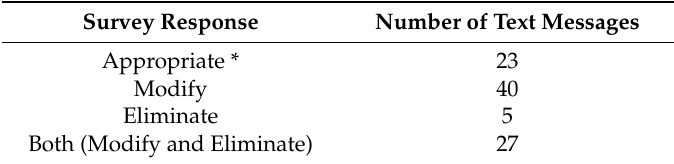
Table 6. Parent survey summary of text messages ( n = 95 texts).